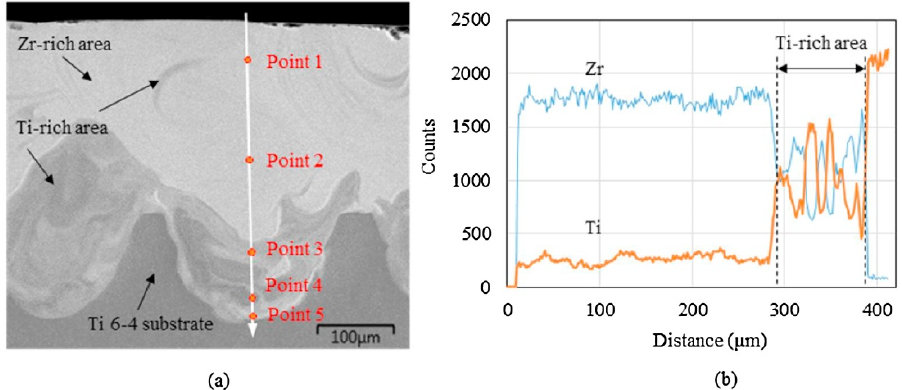
Figure 27. ( a ) BSE image from the first layer of LFPed Zr-based MG on a Ti-6Al-4V alloy and ( b ) EDS line analysis. Reproduced from [107], with permission from Elsevier, 2021.